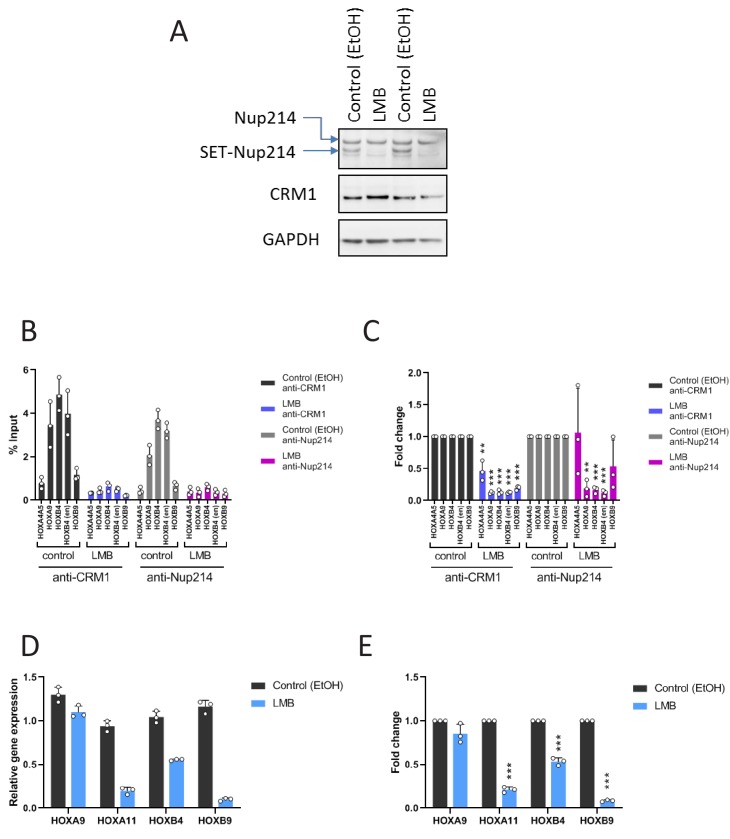
Effect of LMB on the accumulation of SET-Nup214/CRM1 onto HOX regions and gene activation.(A) LOUCY cells were either treated with EtOH (vehicle control) or LMB (10 nM) for 24 hr. Cell lysates (in duplicate) were analyzed by immunoblotting using anti-Nup214, anti-CRM1, or anti-GAPDH antibodies. (B) ChIP-qPCR analysis of CRM1 and Nup214 at HOX gene loci in LOUCY cells cultured either in the presence of EtOH (vehicle control) or LMB (10 nM) for 24 hr. The primer set used was as follows: HOXA4A5 (intergenic region between HOXA4 and HOXA5); HOXA9 (promoter); HOXB4 (promoter); HOXB4 (enhancer); HOXB9 (promoter). Data are presented as mean values ± SEM of three independent experiments (n = 3). (C) The data in (B) were reanalyzed to obtain a ratio by comparing with the value for EtOH treated samples. Data are presented as mean values ± SEM. Asterisks indicate statistical significance determined by Student’s t-test; **p<0.01; ***p<0.001. (D) qPCR analysis of HOX cluster genes (HOXA9, HOXA11, HOXB4, and HOXB9) in LOUCY cells treated either with EtOH (vehicle control) or LMB (10 nM) for 24 hr. GAPDH was used as a reference gene. Data are presented as mean values ± SEM of three independent experiments (n = 3). (E) The data in (D) were reanalyzed to obtain a ratio by comparing with the value for EtOH treated samples. Data are presented as mean values ± SEM. Asterisks indicate statistical significance determined by Student’s t-test; ***p<0.001.